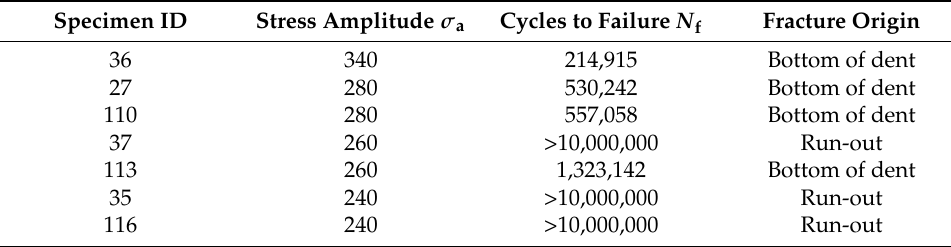
Table A4. Fatigue test results for WN.